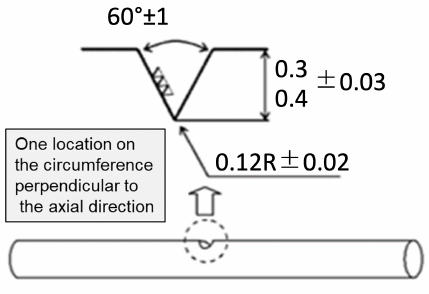
Figure 5. V-notch shape of